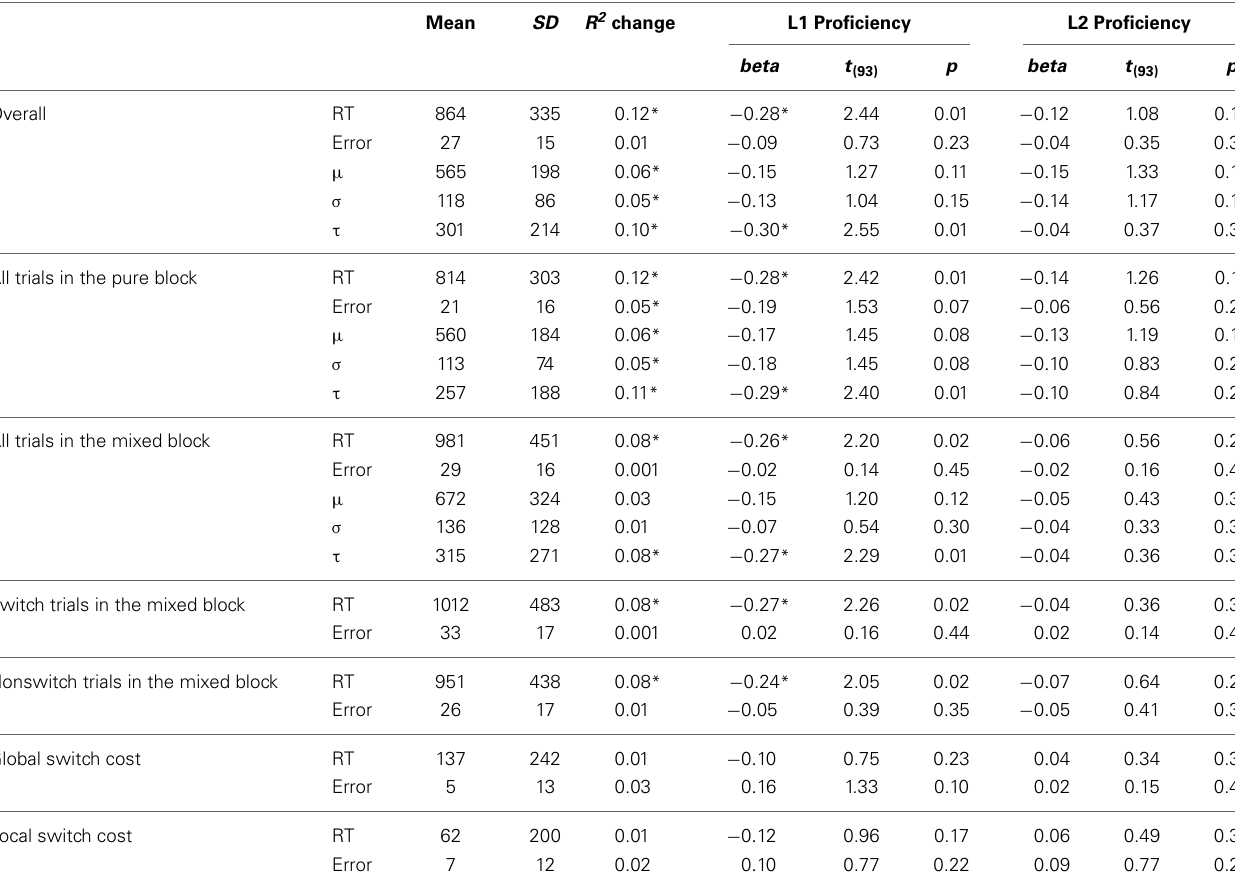
Table 3 | Mean statistics and findings of regression analyses for participants’ performance in the Simon switching